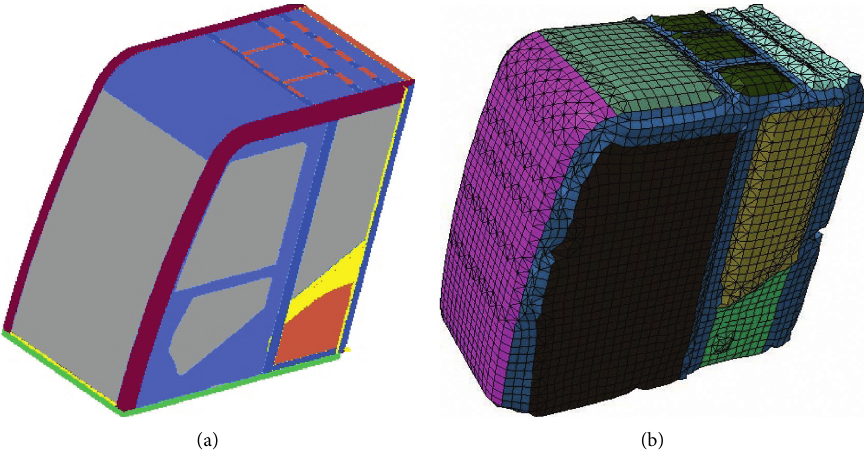
Figure 2: The structural and acoustic model of an enclosed cab. (a) The structural model. (b) The acoustic model.